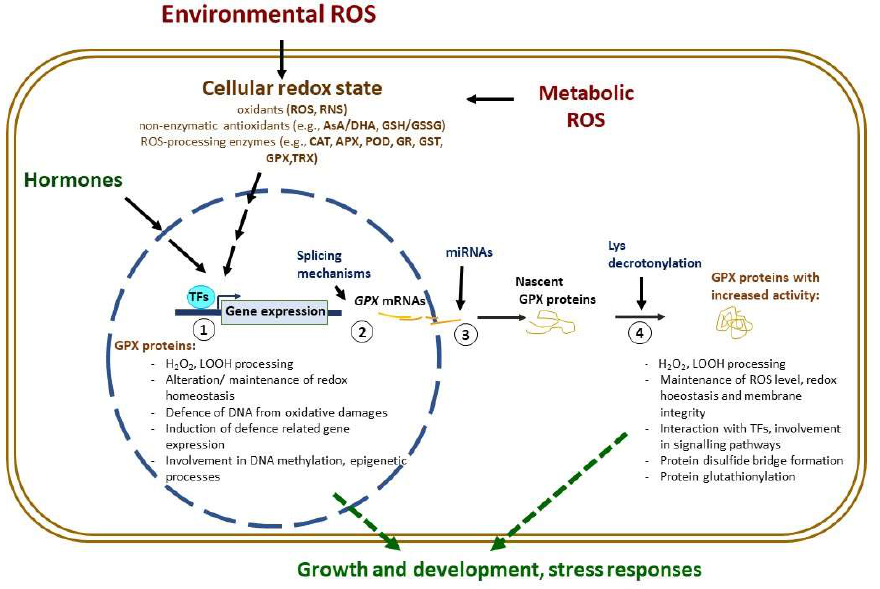
Figure 2. Schematic summary of regulation and main roles of cytoplasmic and nuclear localized plant glutathione peroxidases. (1) Transcriptional control of GPX gene expression via cis -regulatory elements and transcriptional factors, (2) post-transcriptional regulation of GPX mRNAs by splicing mechanisms, (3) GPX mRNAs can be targeted by different types of miRNAs, (4) Lys decrotonylation can increase the GPX protein activity. Abbreviations: APX, ascorbate peroxidase; AsA, ascorbic acid; CAT, catalase; DHA, dehydroascorbate; GPX, glutathione peroxidase; GR, glutathione reductase; GSH, reduced glutathione; GSSG, oxidized glutathione; GST, glutathione transferase; LOOH, lipid peroxide/hydroperoxide; mRNA, messenger RNA; miRNA, microRNA; POD, guaiacol peroxidase; RNS, reactive nitrogen species; ROS, reactive oxygen species; TFs, transcription factors; TRX, thi- oredoxin.